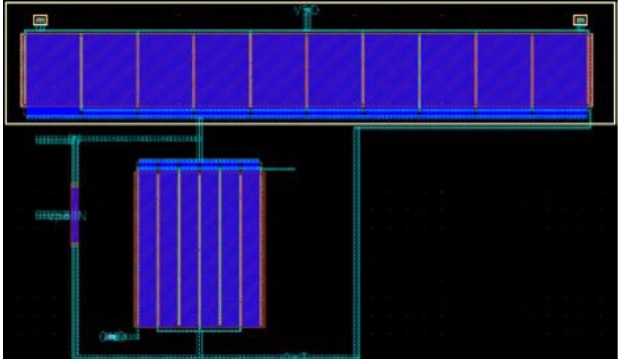
Figure 12. Layout of the current-reuse feedback amplifier used in the WuR. Table 2. Summary of component values for the tuned RFED with feedback amplifier WuR.